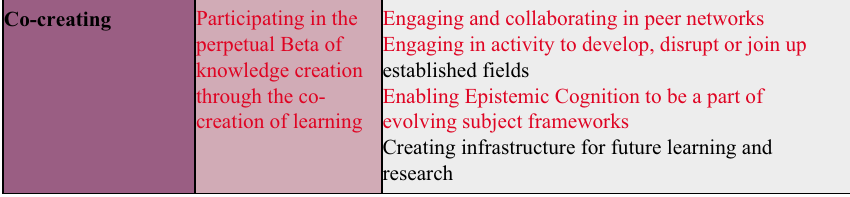
Figure 5. Co-creating ‘type’ Scholarship